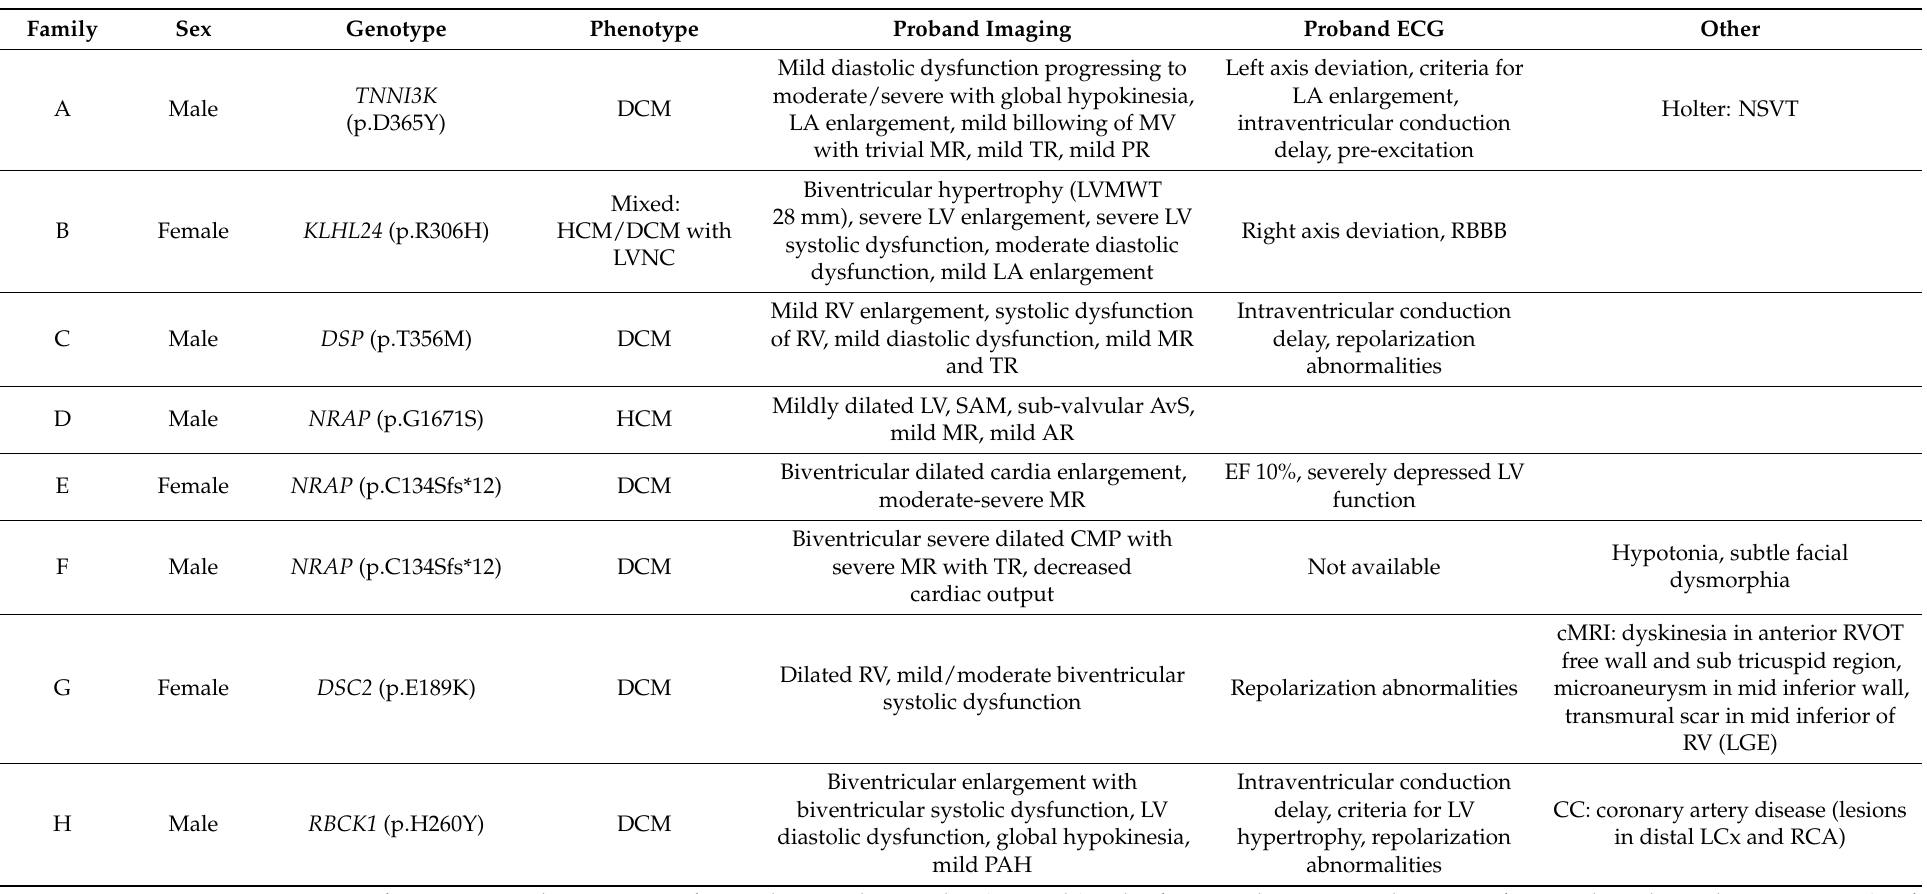
Table 1. Summary of clinical and genetic